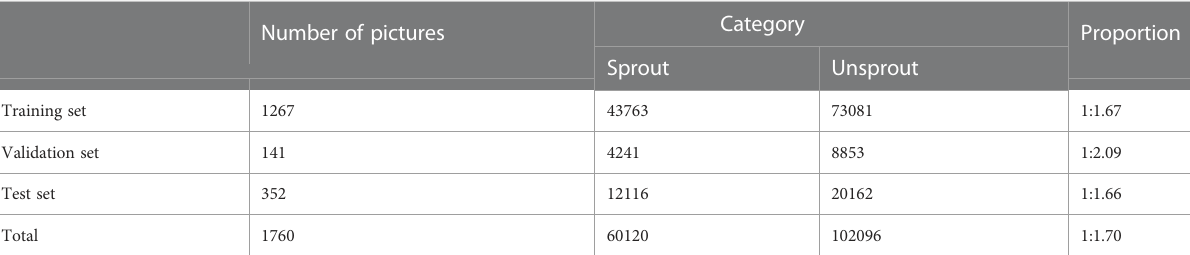
TABLE 1 Wheat seed data set information.